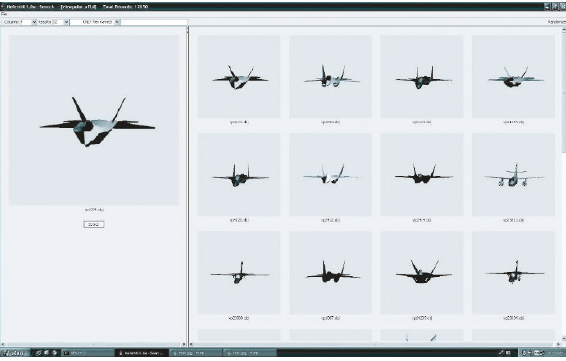
Figure 4: Retrieval of planes. We retrieved most of the planes (ap- proximately 80%) without inlayer despite the fact that the reference model had a very low resolution. Only the first results are